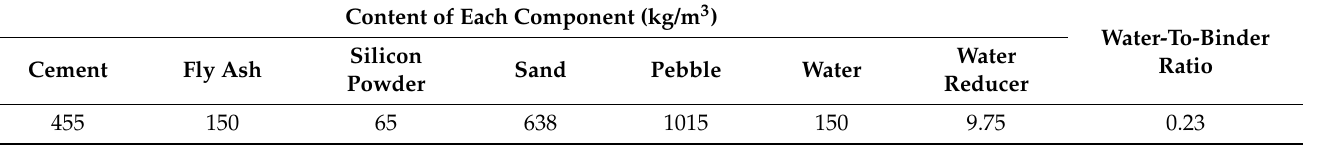
Table 2. The C100 concrete mixture design.